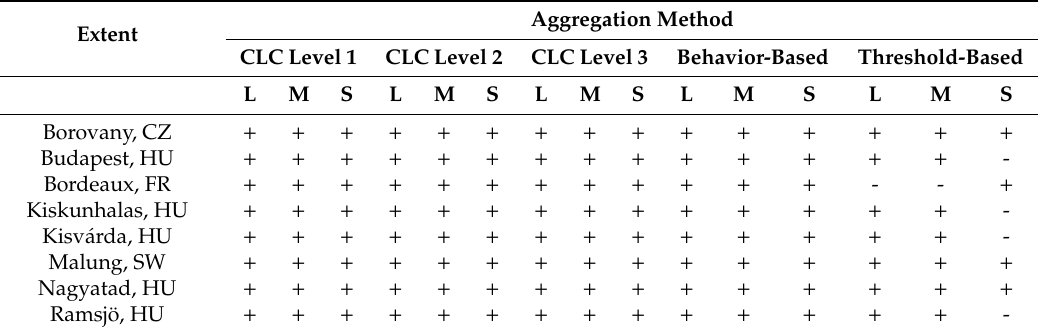
Table 1. A matrix of extents and aggregation methods concerning how we ran our models. Aggregation methods are named according to Section 2.3. L, M and S letters are abbreviations for Large, Medium and Small zoom levels, referring to their area size. Positive ( + ) signs denote that model was run in the relevant extent, zoom level and aggregation method according to their positions in the matrix. Negative (–) signs denote that model was not run for that specific case.